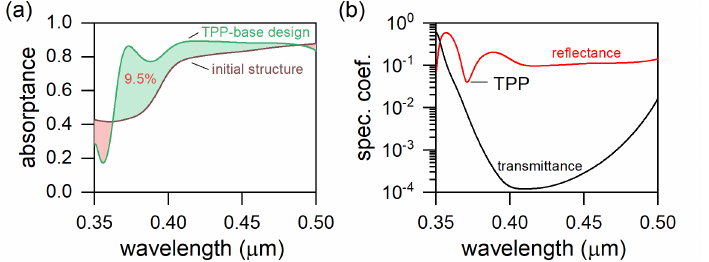
Figure 3. ( a ) Absorptance spectra of the PSL–Al (initial structure with aluminum film) and the PSL–PhC (TPP-based design); ( b ) reflectance and transmittance spectra of the PSL–PhC